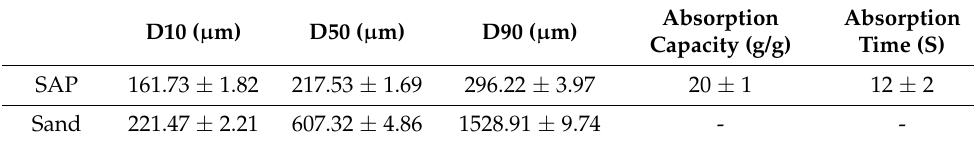
Table 3. Particle size distribution and physical properties of the SAP and